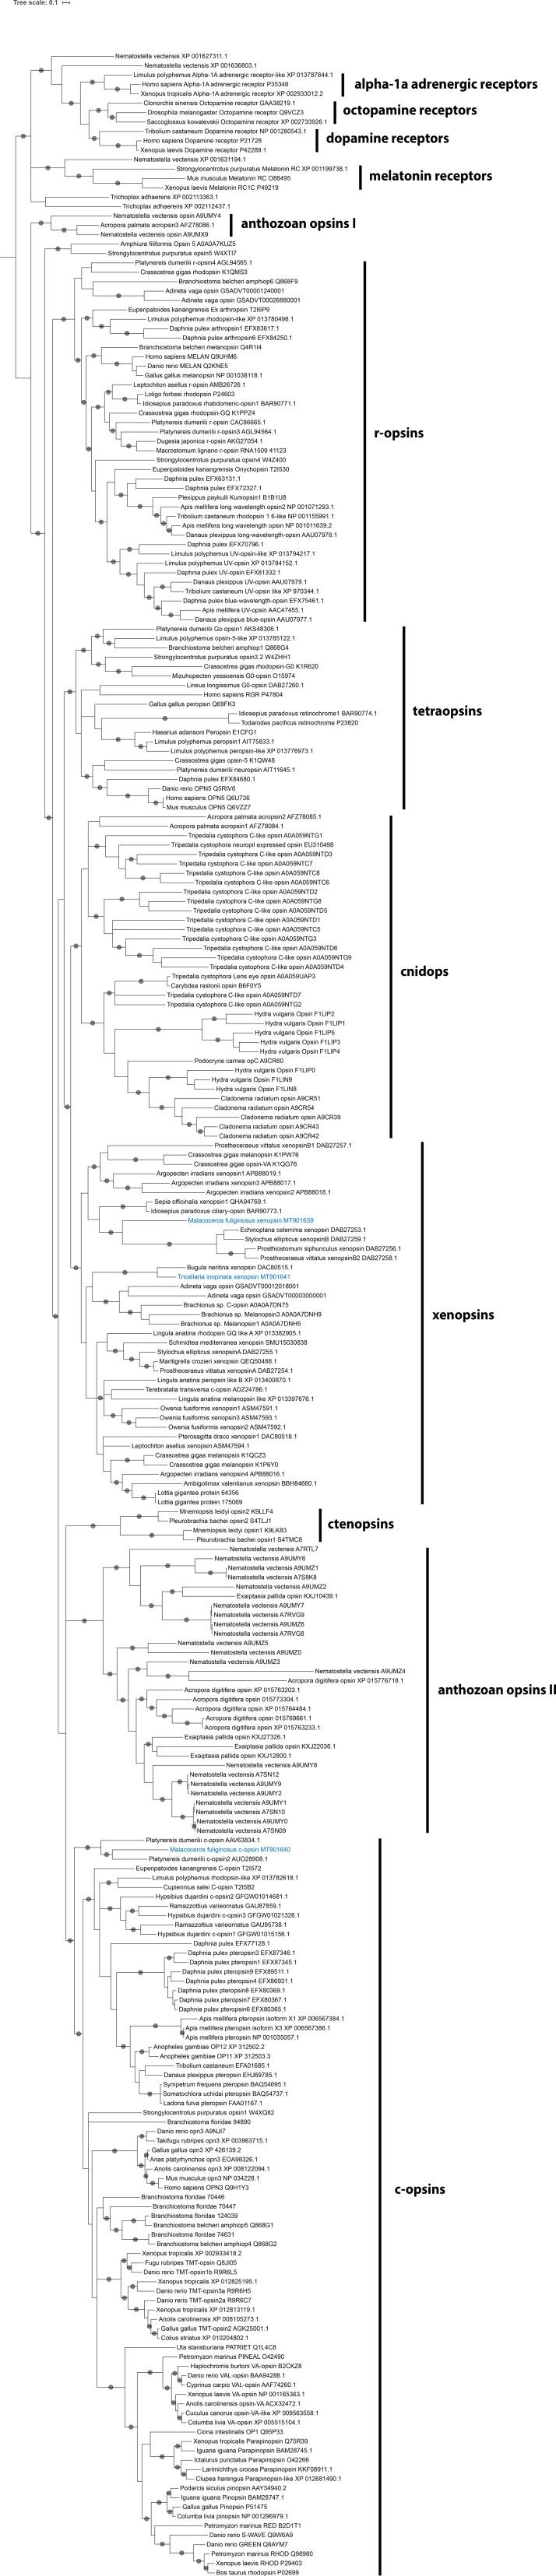
Bayesian analysis (Phylobayes) of sequence alignment used in Figure 2.Parametric Γ modeling of the dataset specific substitution matrix (DS-GTR) generated by Vöcking et al., 2017. Consensus tree of two out three chains (90.000 cycles, burn-in 18.000, mean difference 0.079). Labeled nodes have support values of posterior probability ≥0.95 (black dot). The sequences investigated in this study are highlighted in blue.